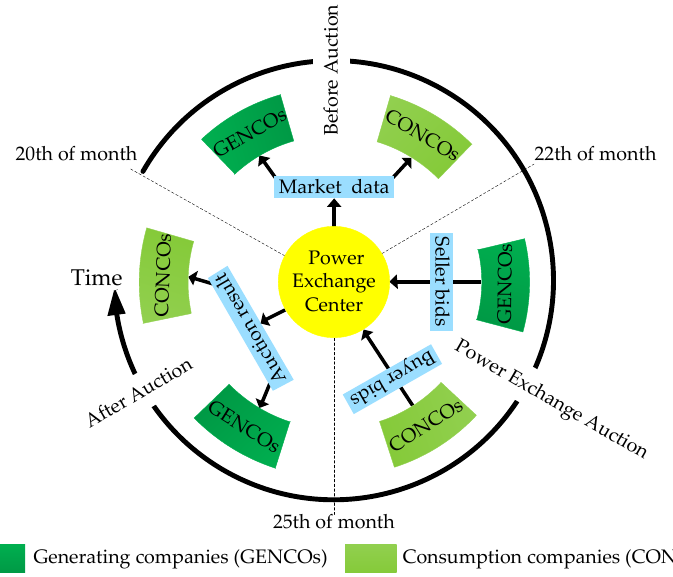
Figure 3. The process and key times of Yunnan’s monthly electricity market.